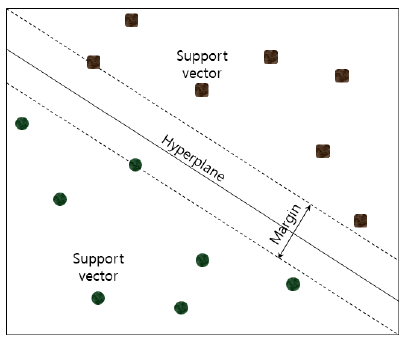
Figure 6. Illustration of a typical SVM architecture.